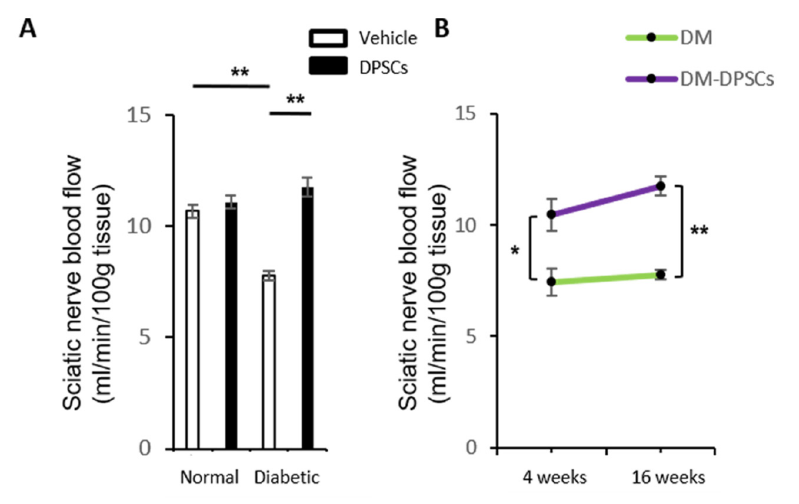
Figure 5. Sciatic nerve blood flow. ( A ) Sciatic nerve blood flow at 16 weeks after hDPSC transplan- tation. ( B ) Sciatic nerve blood flow at 4 and 16 weeks after hDPSC transplantation in diabetic mice. The results are expressed as the mean ± SEM ( n = 4). * p < 0.05, ** p < 0.01. DM: diabetes mellitus